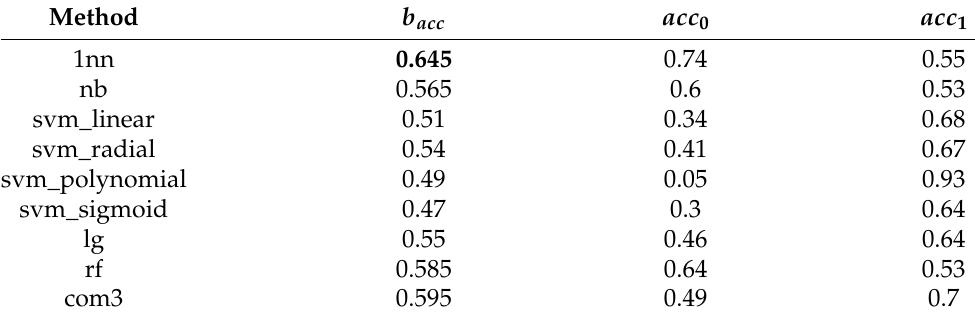
Table 10. Summary of results for data.bee3.2 with baseline correction.